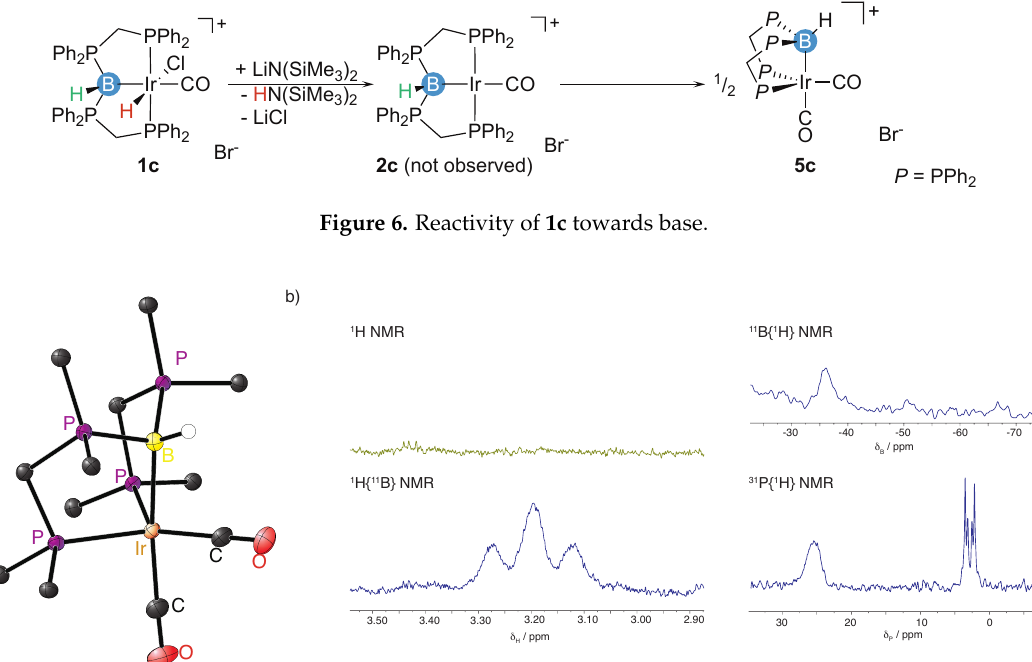
Figure 6. Reactivity of 1c towards base.